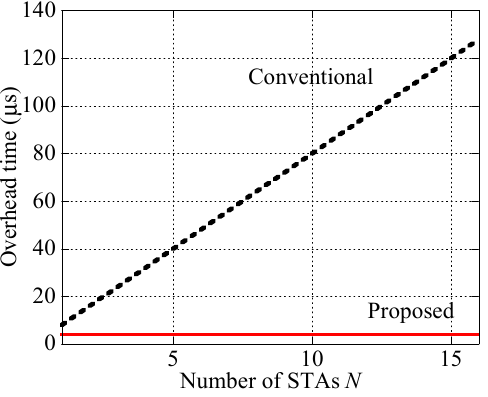
Figure 8. Overhead time vs. number of STAs.